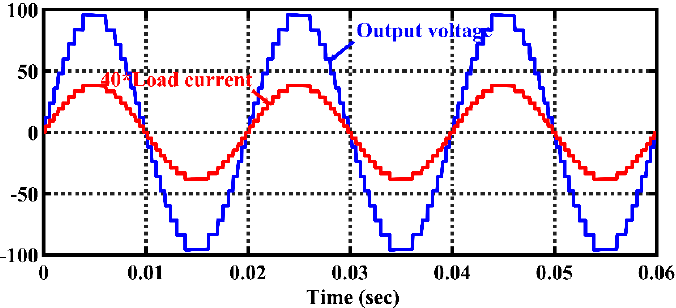
Figure 11. Output voltage and load current for asymmetric configuration.